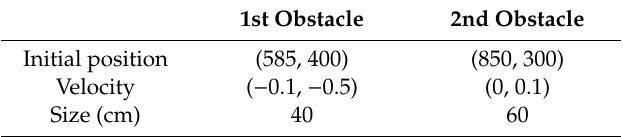
Table 6. Virtual obstacle parameters for testing moving obstacle avoiding ability in first